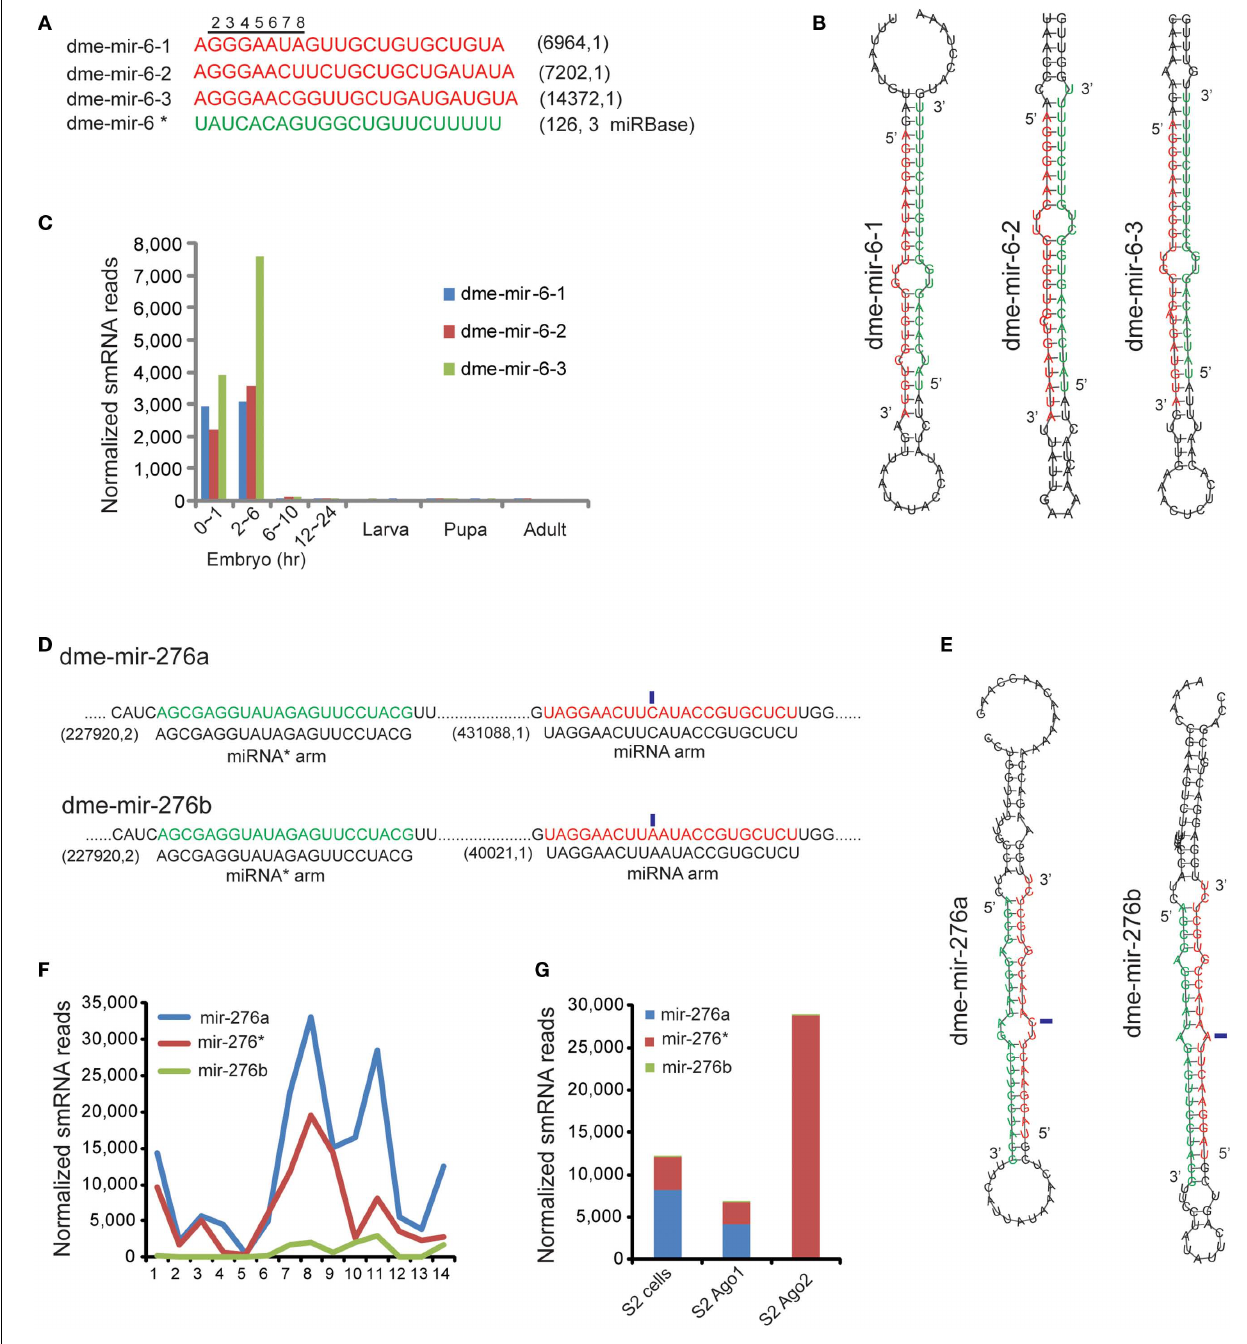
corrected mature sequences of miR-6 family. (D) The dme-mir-276a and 276b contain identical miRNA ∗ arms but different miRNA arms with one nucleotide variation (marked by blue rectangles). (E) Hairpin structures of dme-mir-276a and 276b with highlighted miRNA ∗ arm and miRNA arm. (F) Expression abundance of dme-mir-276a, mir-276b, and their passenger strand mir-276 ∗ in Drosophila development. (G) Mir-276 ∗ are preferentially associated with Ago2, while higher proportion of mir-276a was found in